Question: Summarize what this figure shows in one sentence.
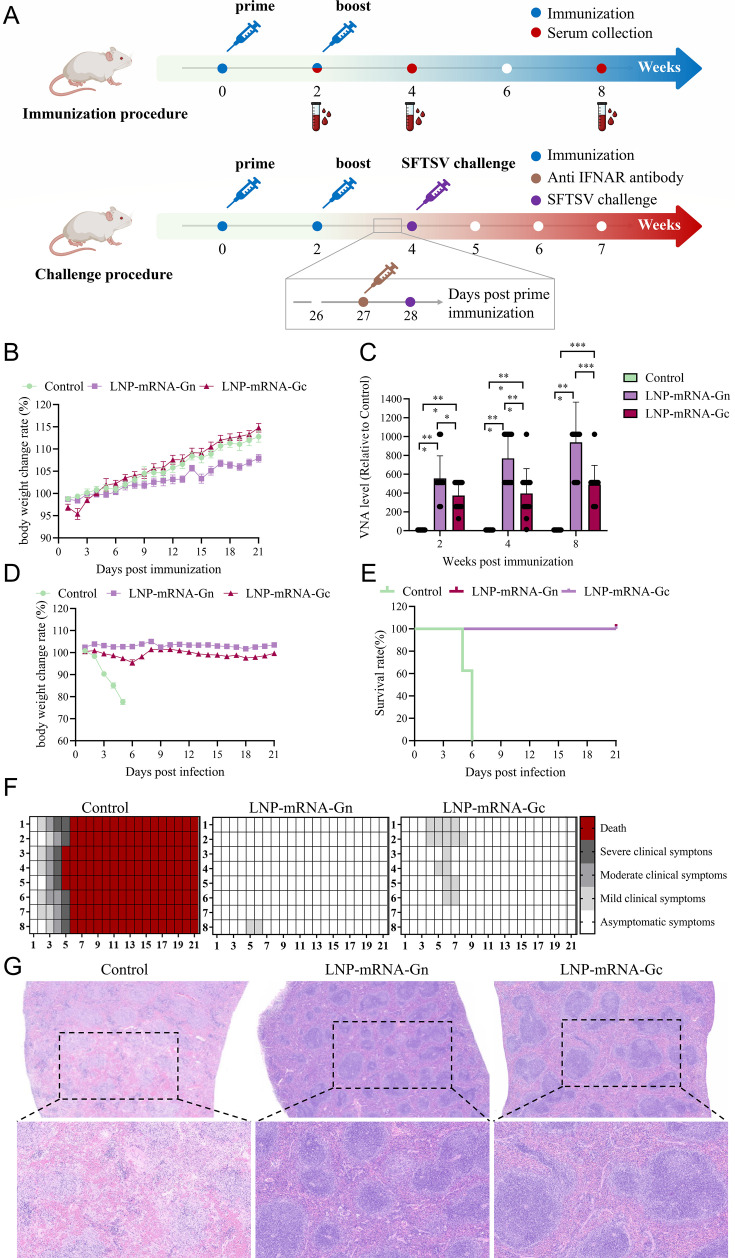
Answer: Efficacy of the mRNA vaccines in mice. ( A ) Schematic diagram of the immunization protocol, blood collection time points, and SFTSV challenge schedule in mice. ( B ) Body weight was monitored daily for 21 days postimmunization (eight wild-type mice per group; values are means ± SEM). ( C ) The specific VNAs from mouse blood samples against SFTSV were detected at 2, 4, and 8 weeks postimmunization (12 wild-type mice per group; values are means ± SEM; ANOVA with Tukey’s multiple comparisons test). ( D ) The body weights of the IFNAR-blocked mice were monitored daily for 21 days after the lethal SFTSV challenge (eight IFNAR-blocked mice per group; values are means ± SEM). ( E ) Survival curves of IFNAR-blocked mice were monitored daily for 21 days after the lethal SFTSV challenge (eight IFNAR-blocked mice per group). ( F ) Clinical symptom scores of the IFNAR-blocked mice were monitored daily after the lethal SFTSV challenge. ( G ) The spleens of vaccinated (LNP-mRNA-Gn/Gc) and unvaccinated mice were collected for histopathological examination (scale bar = 200 µm). * P < 0.05, ** P < 0.01 and *** P < 0.001.